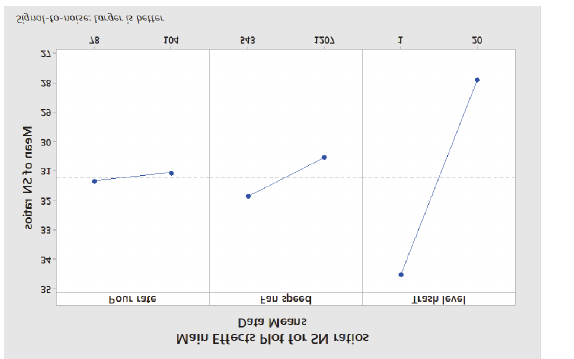
Fig. 10. Optimal parameter setting for the production factor that yield maximum returns